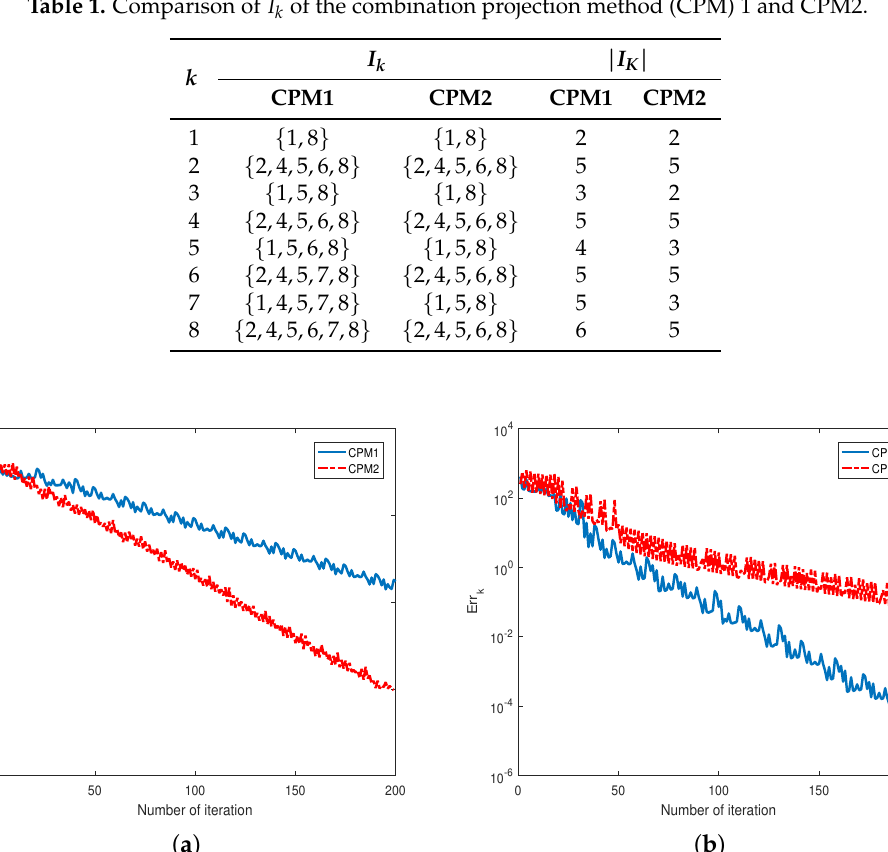
Figure 1. The comparison of two choices of β Number of